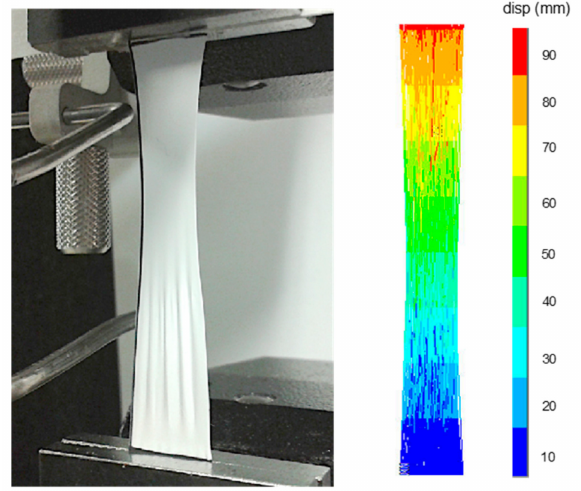
Figure 2. Sample clamped in the jaws of tensile testing machine during uniaxial tensile test ( left ). Deformed shape of the electrospun structure FE model in tension under displacement 100 mm ( right